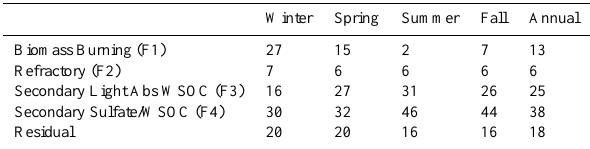
Table 3. Seasonal and annual source contributions of each PMF factor to PM 2 . 5 mass (% of PM 2 . 5 mass). Winter (J, F, D), Spring (M, A, M), Summer (J, J, A) and Fall (S, O, N).